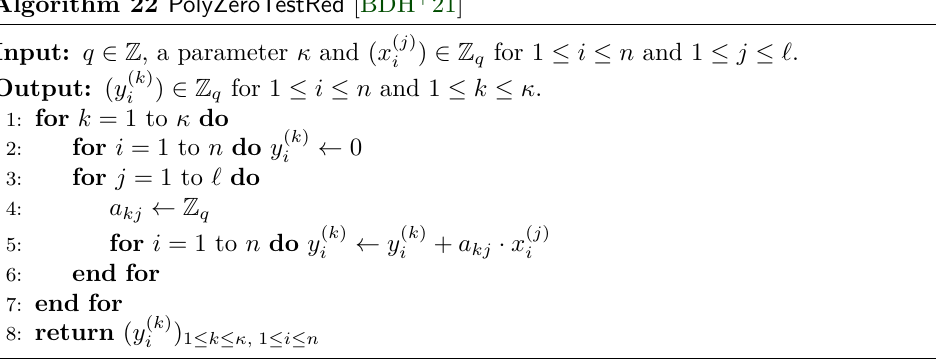
Algorithm 22 PolyZeroTestRed [BDH +